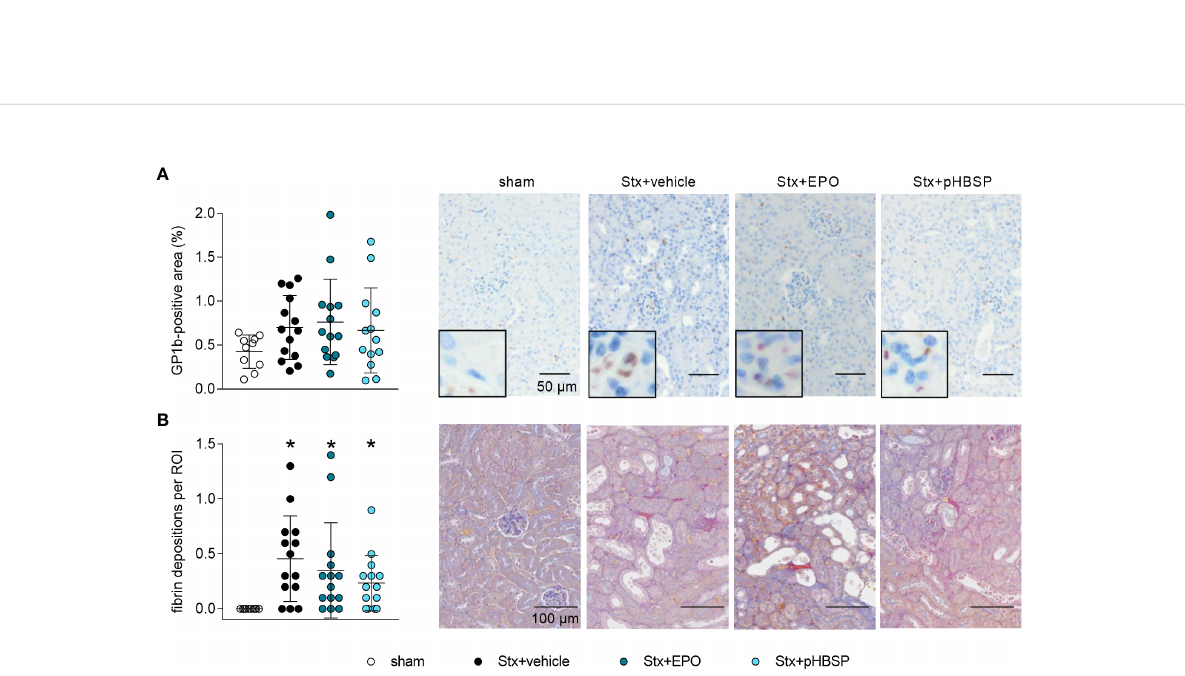
FIGURE 6 Effects of EPO and pHBSP treatment on microangiopathy in mice with HUS. Thrombocytes (indicated by glycoprotein 1b (GP1b) staining) and renal fi brin depositions (indicated by acid fuchsin orange G (SFOG) staining) were assessed on day 7 of HUS experiment. Quanti fi cation data and representative images of (A) immunohistochemical staining of thrombocytes (sham n = 10, Stx+vehicle n = 14, Stx+EPO n = 14, Stx+pHBSP n = 13) and (B) fi brin depositions (sham n = 10, Stx+vehicle n = 14, Stx+EPO n = 14, Stx+pHBSP n = 14) in kidney sections of sham mice and Stx- challenged mice. Quantitative data are expressed as scatter dot plot with mean ± SD. *P < 0.05 vs. sham (Kruskal-Wallis test, Dunn ’ s multiple comparison test), scale bar 100